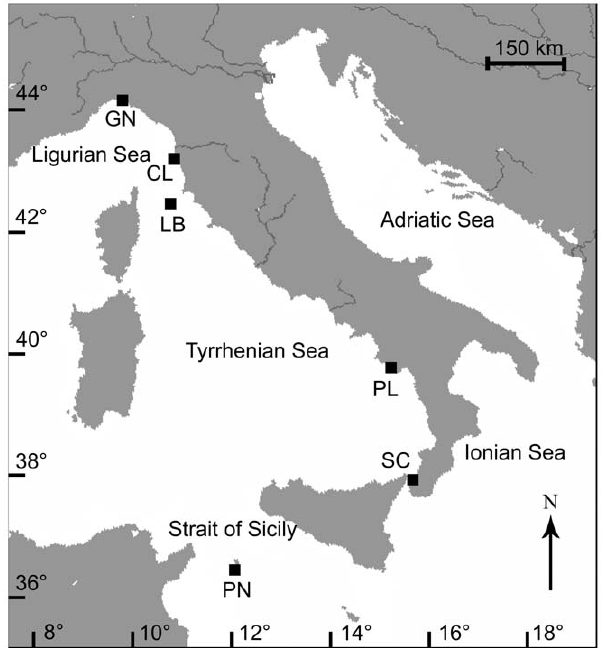
Figure 2. Map of the Italian coastline indicating sites where corals were collected. Abbreviations and coordinates of the sites in decreasing order of latitude: GN Genova, 44 u 20 9 N, 9 u 08 9 E; CL Calafuria, 43 u 27 9 N, 10 u 21 9 E; LB Elba Isle, 42 u 45 9 N, 10 u 24 9 E; PL Palinuro, 40 u 02 9 N, 15 u 16 9 E; SC Scilla, 38 u 01 9 N, 15 u 38 9 E; PN Pantelleria Isle, 36 u 45 9 N, 11 u 57 9 E.